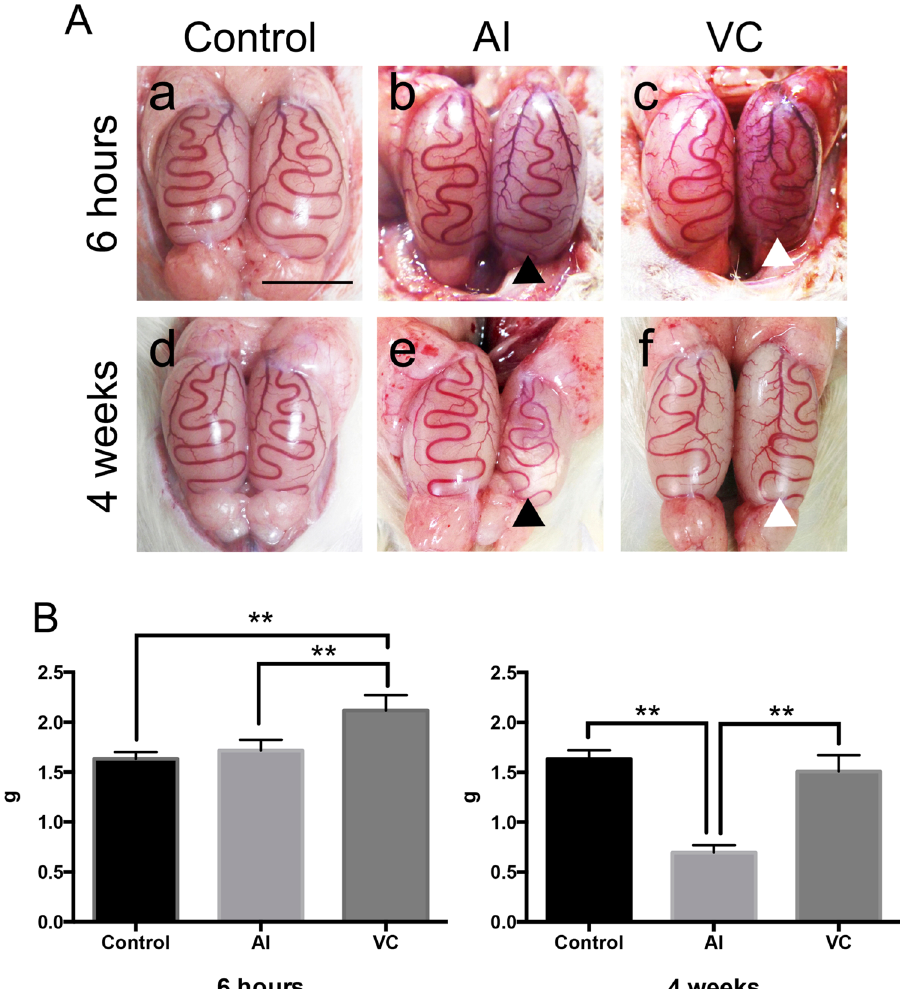
Figure 1. Macroscopic findings and organ weights of rat testes with arterial ischaemia (AI) and venous congestion (VC) and after their reperfusion. A: Macroscopic findings. ( a ) Control. ( b ) 6 h after AI. ( c ) 6 h after VC. ( d ) control after 4 weeks. ( e ) 4 weeks after reperfusion of AI. ( f ) 4 weeks after reperfusion of VC. The black arrowheads indicate the testes that had received AI and its reperfusion. The white arrowheads indicate the testes that had received VC and its reperfusion. Bar = 1 cm. B: Changes in testes weights in rats with AI or VC. Data are expressed as means ± SD, and the two-way analyses of variance and Tukey–Kramer tests were used for statistical analyses. P > 0.05 was considered as indicating a nonsignificant difference. ** P <